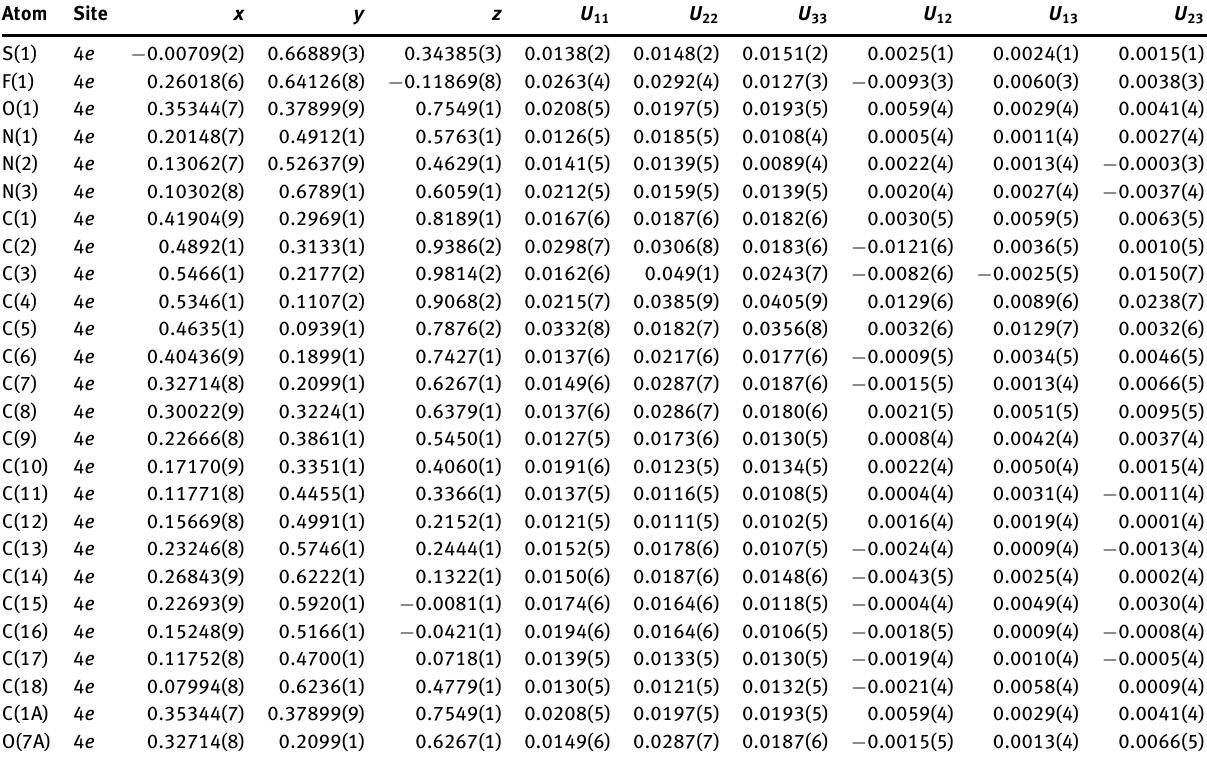
Table 3: Fractional coordinates and atomic displacement parameters (Å 2